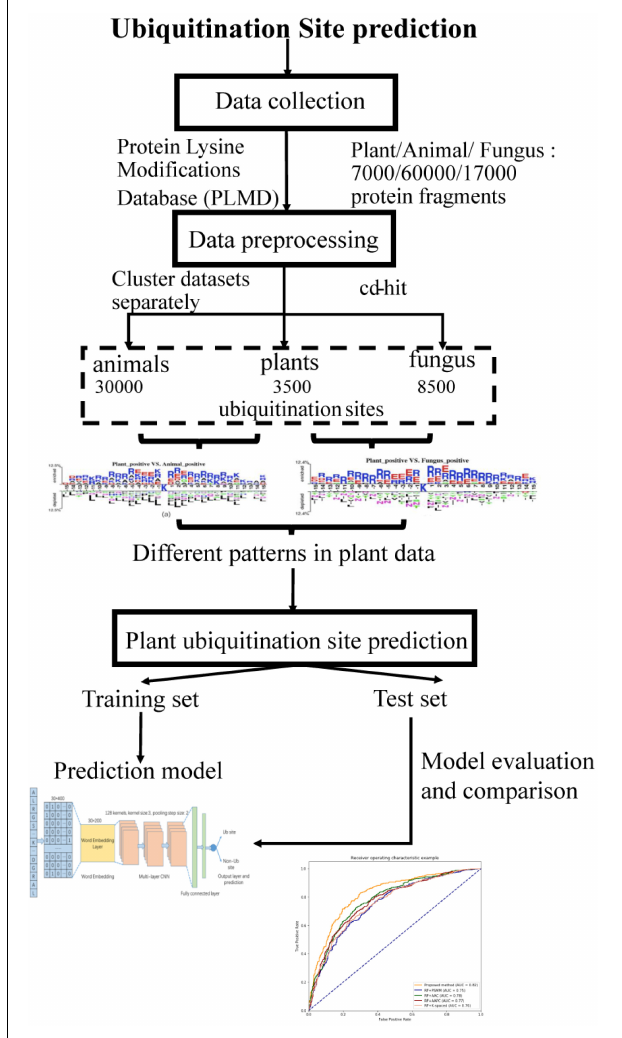
FIGURE 1 | Schematic diagram of the workflow for this